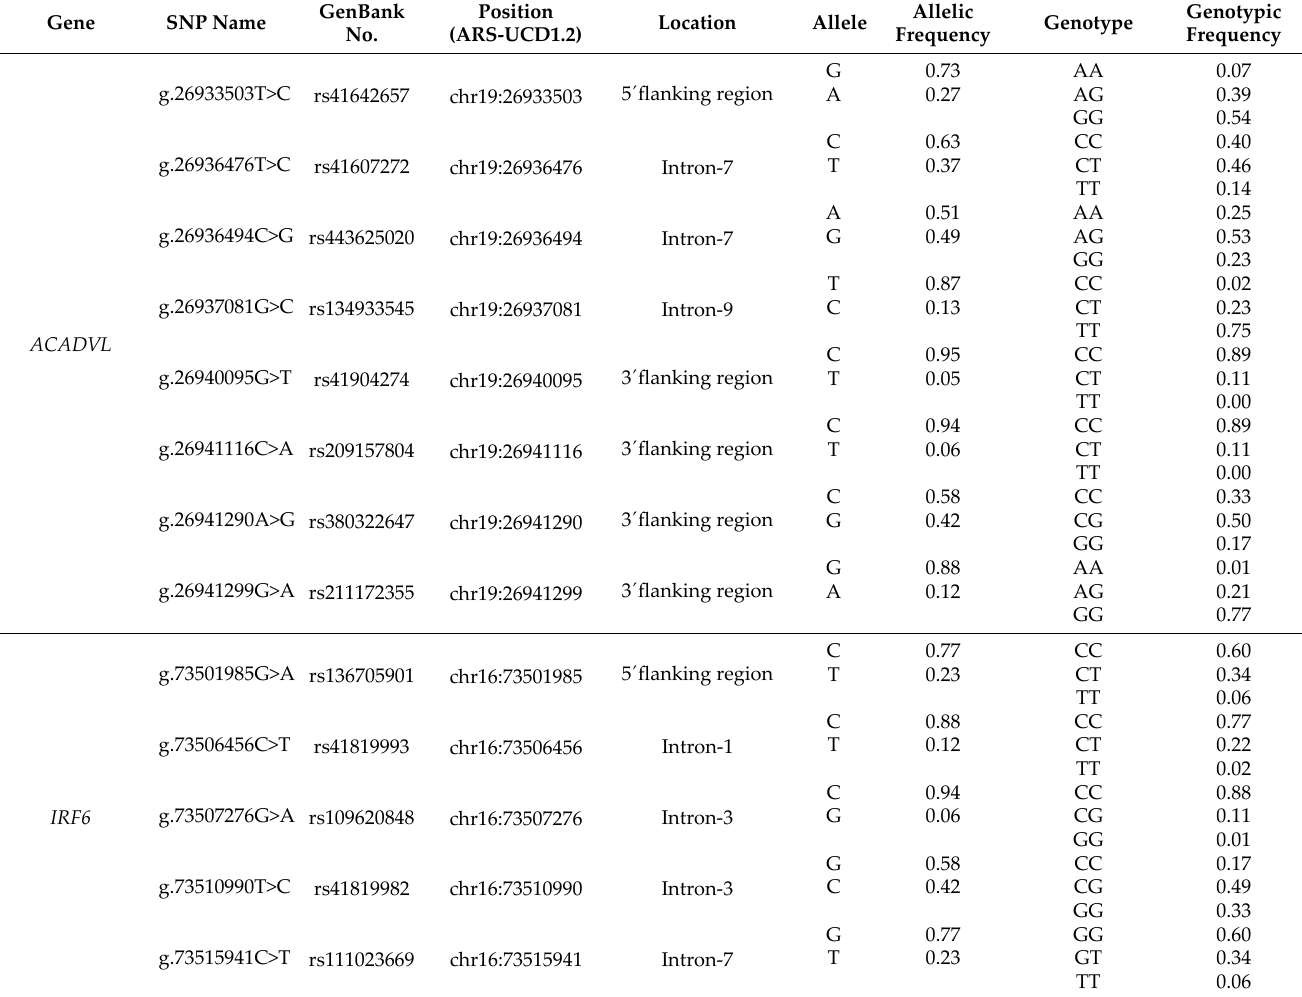
Table 1. Detailed information about the identified